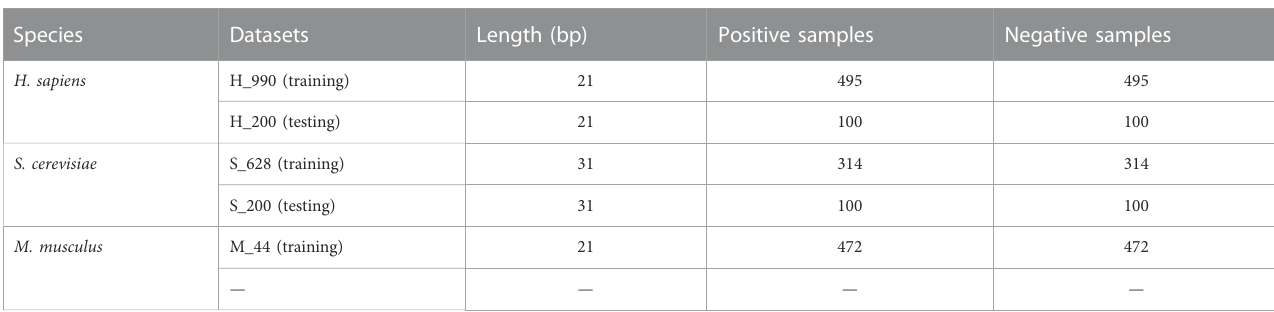
TABLE 1 Training and independent dataset information. Species